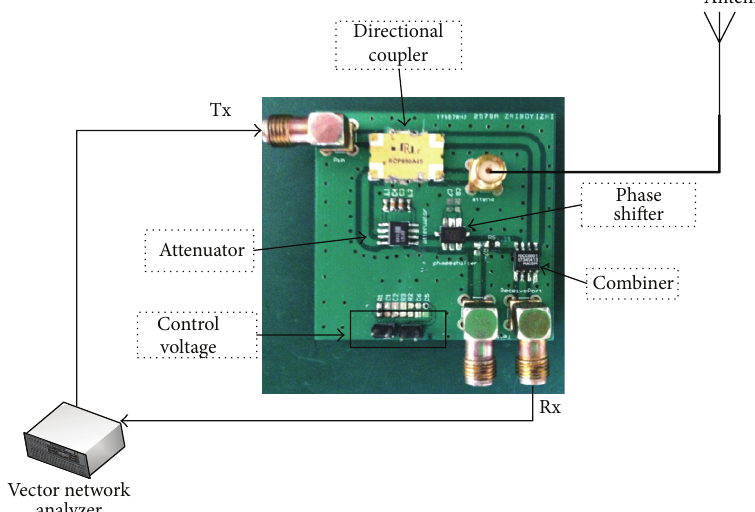
Figure 7: Photograph of the fabricated CLS circuit, including the schematic diagram of the experimental setup.